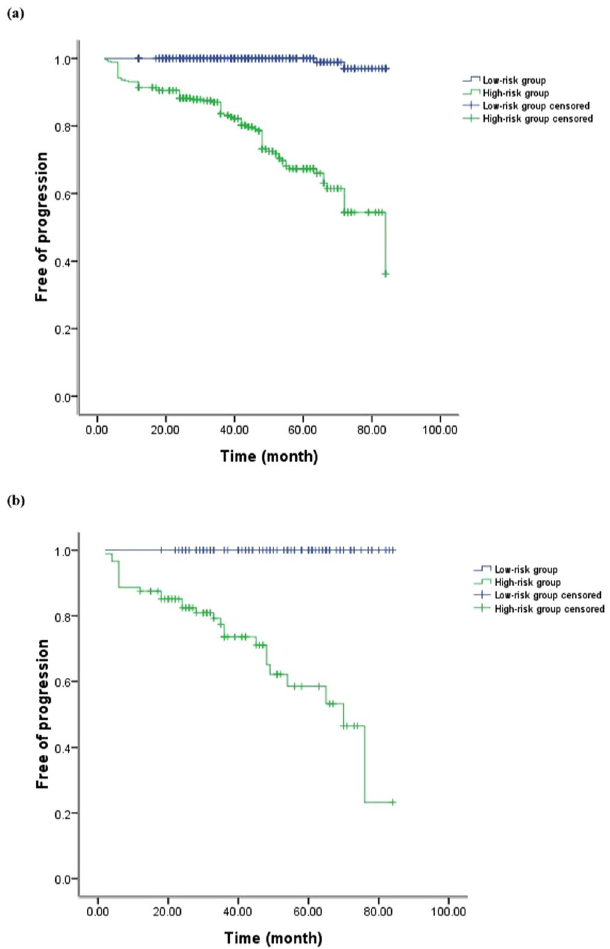
Figure 4. Kaplan-Meier survival curves of the development cohort ( a ) and the validation cohort ( b ) according to risk stratification of predicted free-of-progression